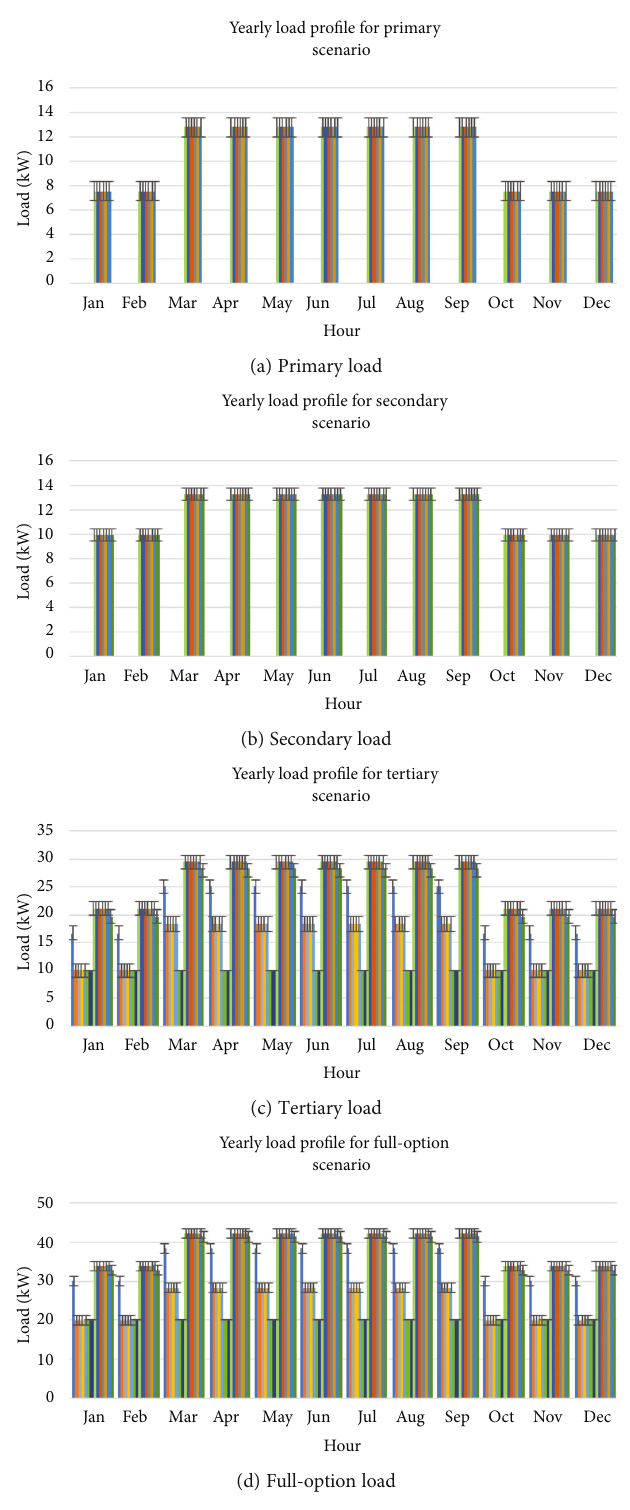
Figure 6: Monthly load pro fi le for all four